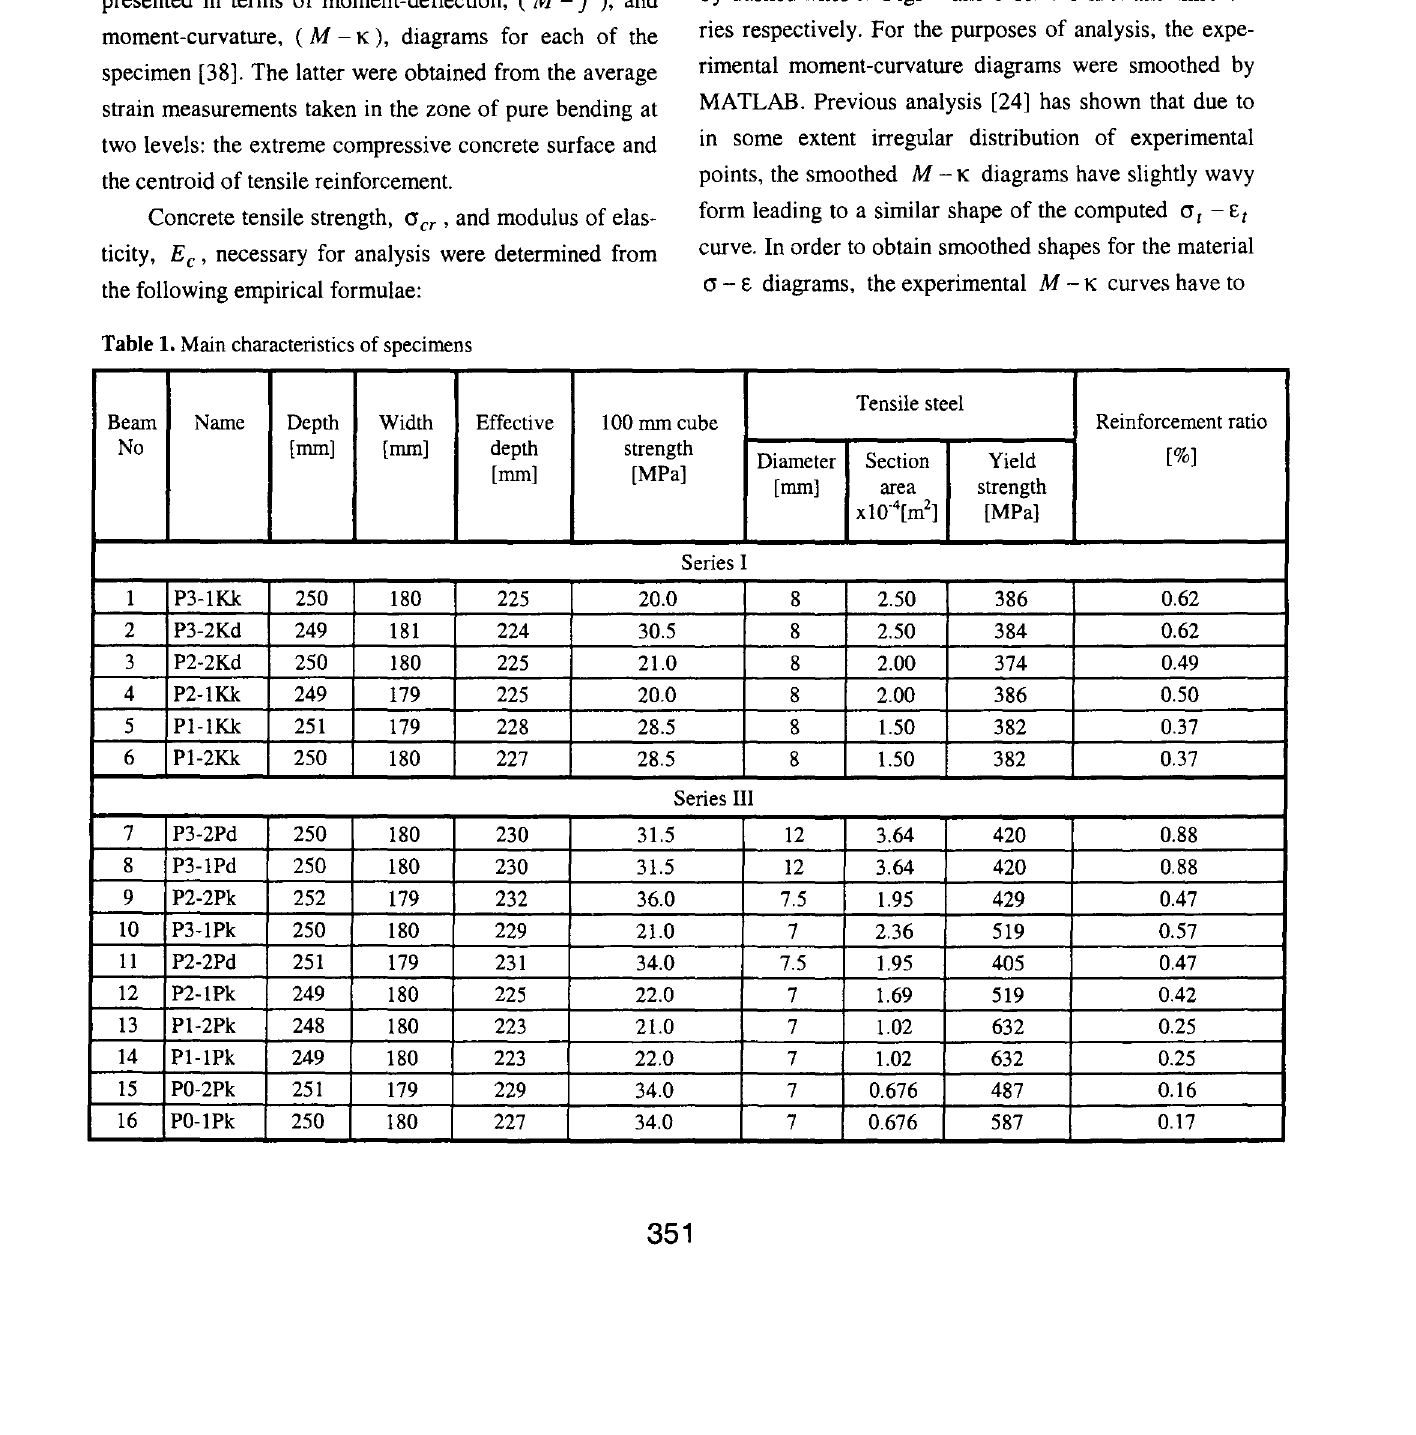
Table 1. Main characteristics of